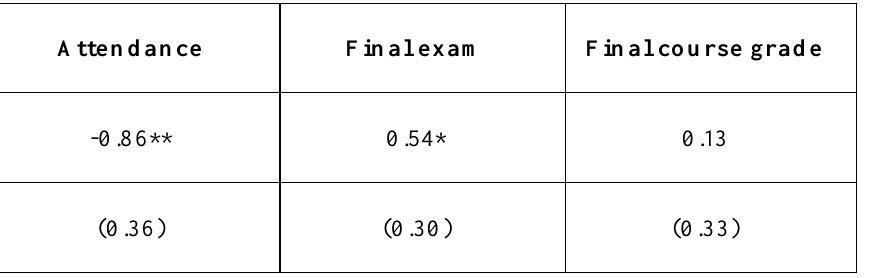
Estimation of the Effect of Using the Khan Academy Collection 1 Versus the Use of Traditional Textbooks (Scenario